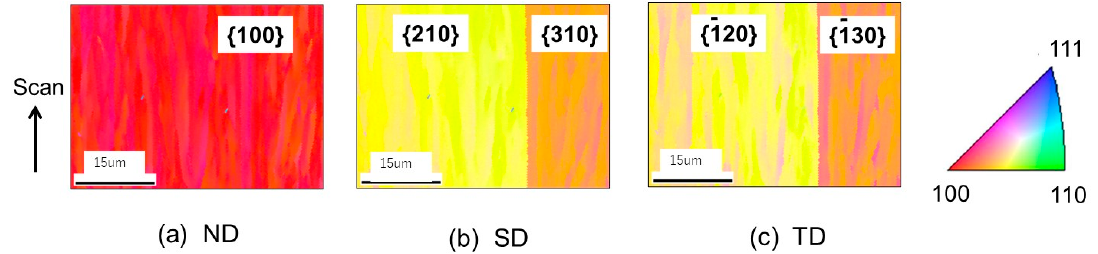
Figure 12. IPF maps of the crystallized film at an increased effective laser power a little from the lateral growth threshold; ( a ) normal direction, ( b ) scan direction, and ( c ) transverse direction. The SiO 2 cap thickness was 123 nm, and the power was 1.6 W. The scan velocity was 15 mm/s. After Sasaki et al. [53].